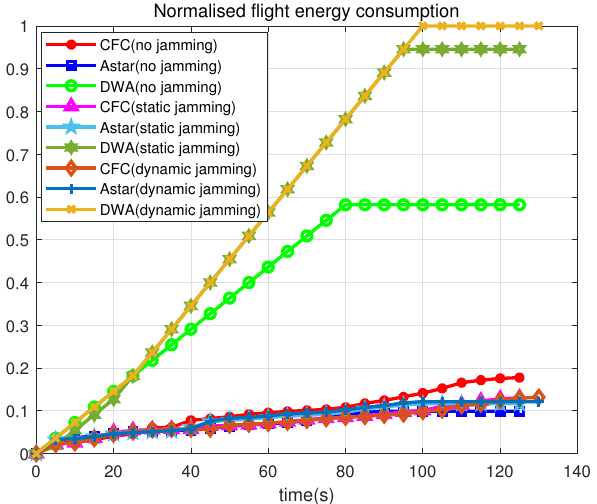
Figure 8. Variation in flight energy consumption for three algorithms in different